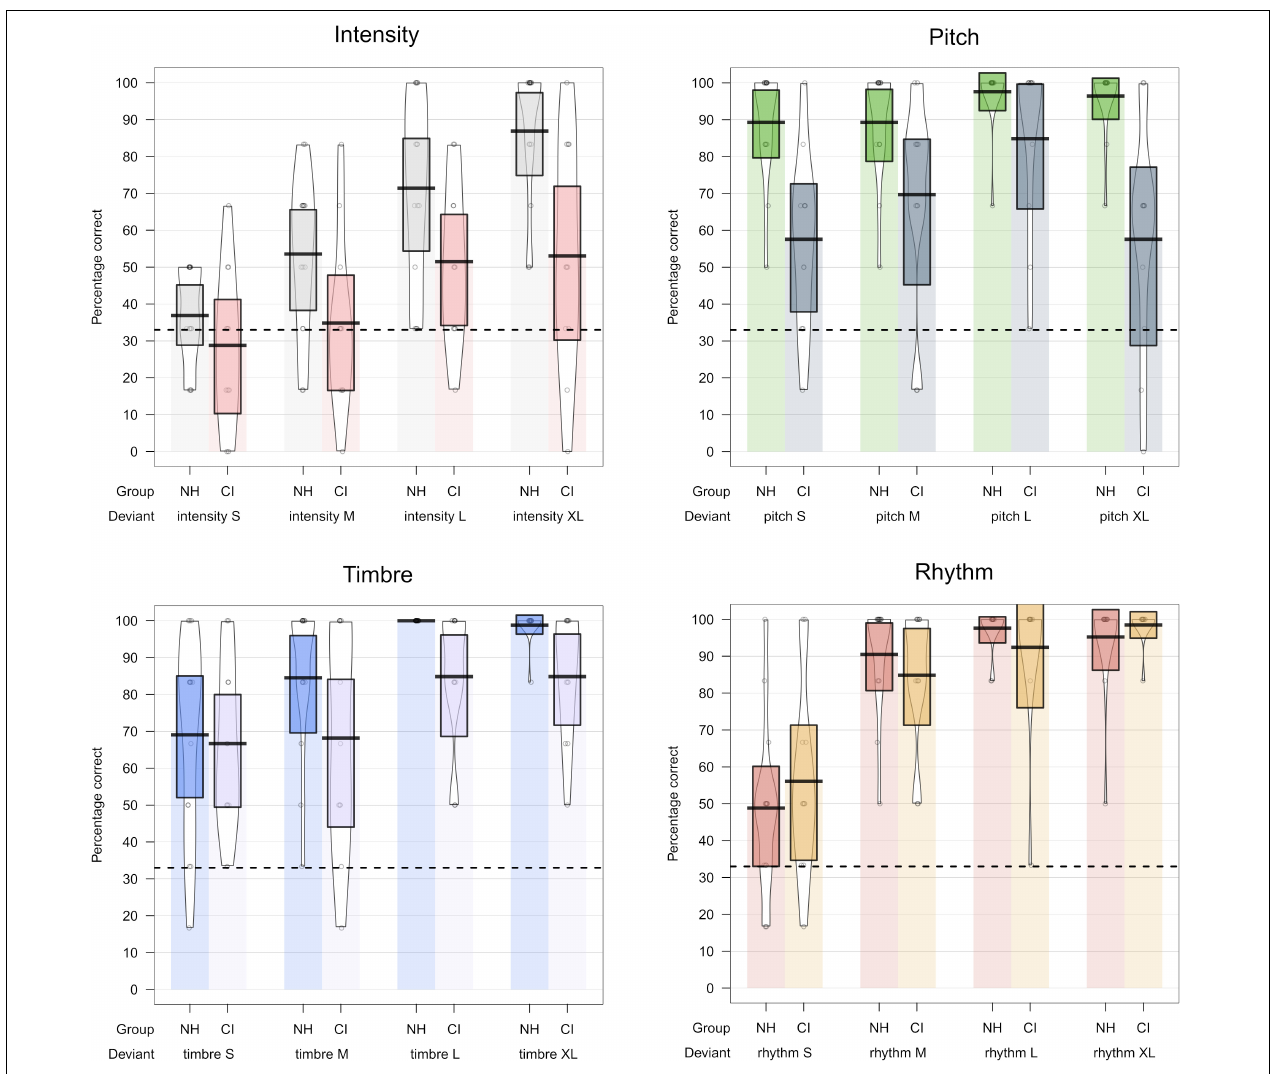
FIGURE 5 | Violin plots showing behavioral hit rates for each feature, level, and group. Dotted line indicates chance